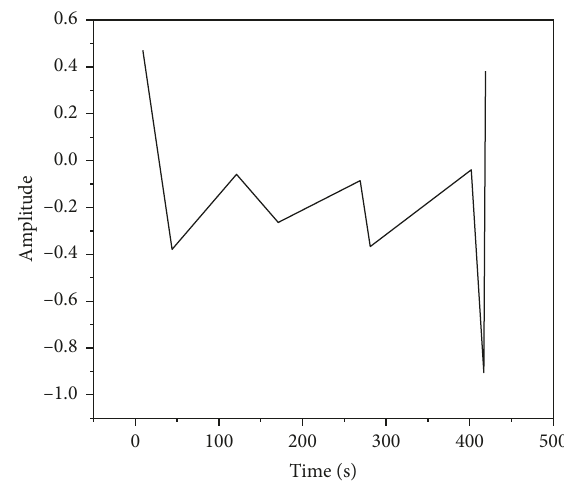
Figure 1: Time-domain spectral lines of sound data in transformer